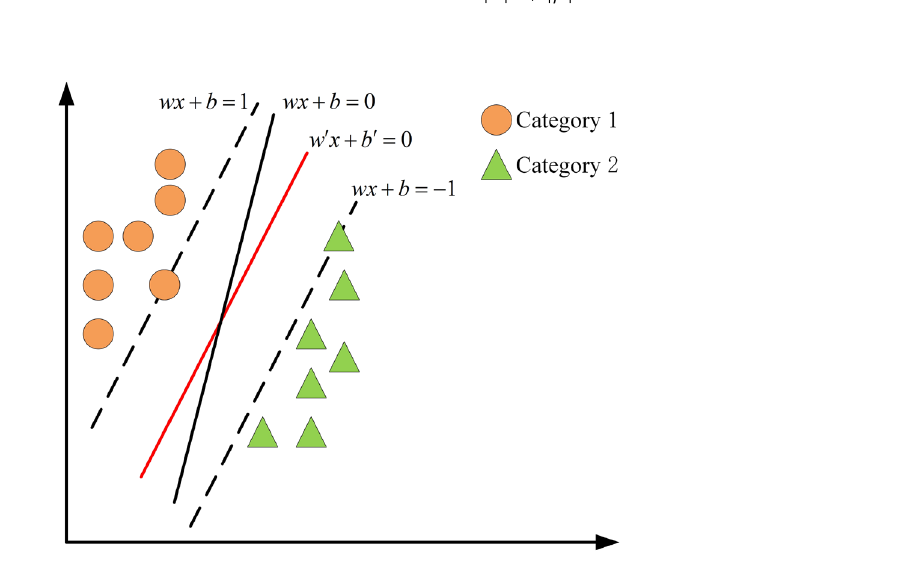
Figure 3. Traditional SVM classification